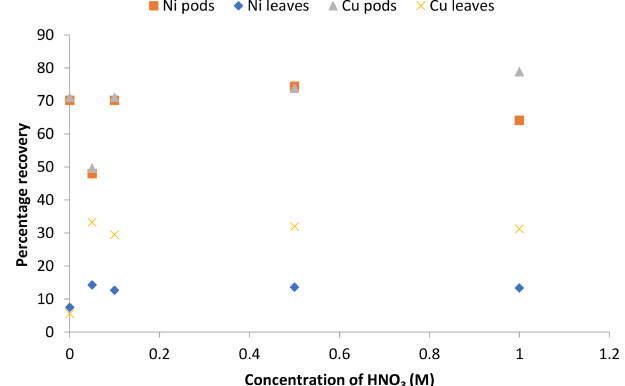
Figure 8. Recovery study of the adsorbed Ni(II) and Cu(II) ions from the pods and leaves of Delonix regia